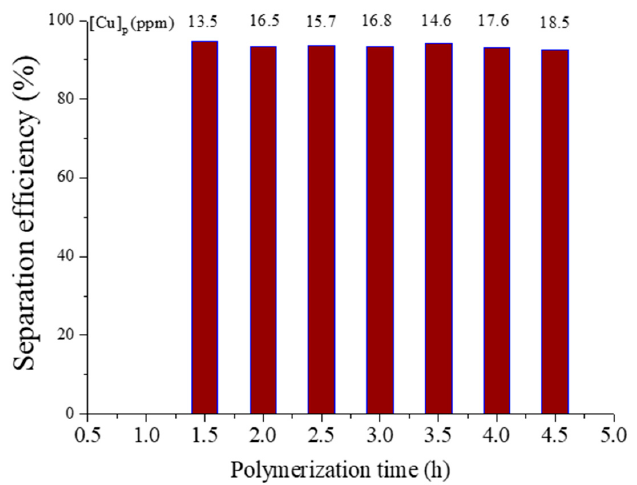
Figure 6. Effect of polymerization time on separation efficiency of the copper catalyst. Polymerization conditions: [MMA] 0 /[EBPA] 0 /[CuBr 2 ] 0 /[PMDETA] 0 = 400/1/0.25/0.5, m [Cell-SH] = 50 mg, V MMA = 2.0 mL, V anisole = 1.0 mL, Temperature = 90 °C. [Cu] P : the copper residual concentration in obtain polymer.